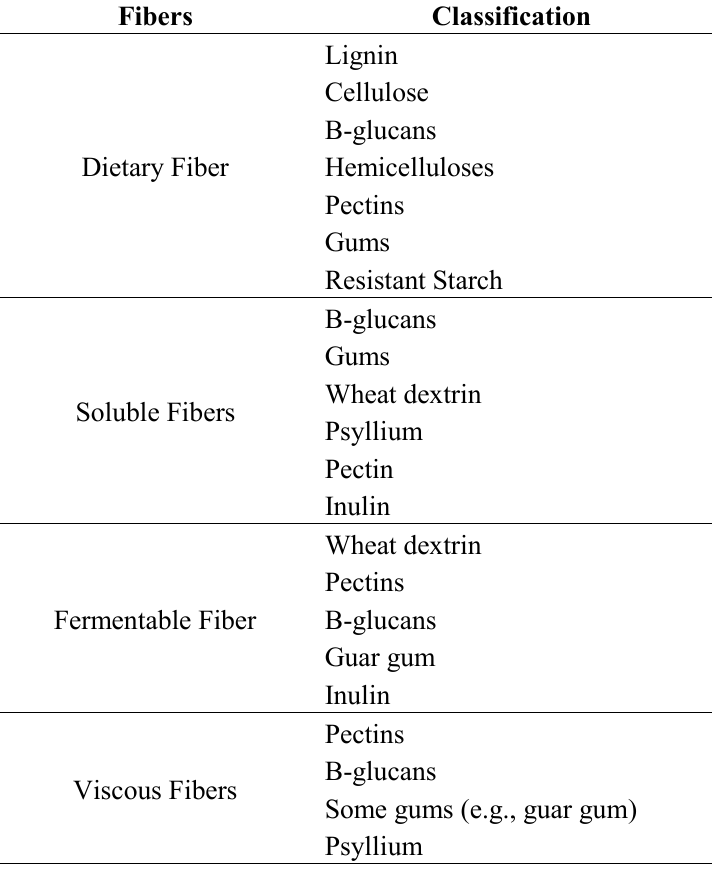
Table 1. Classification of fibers based on four characteristics